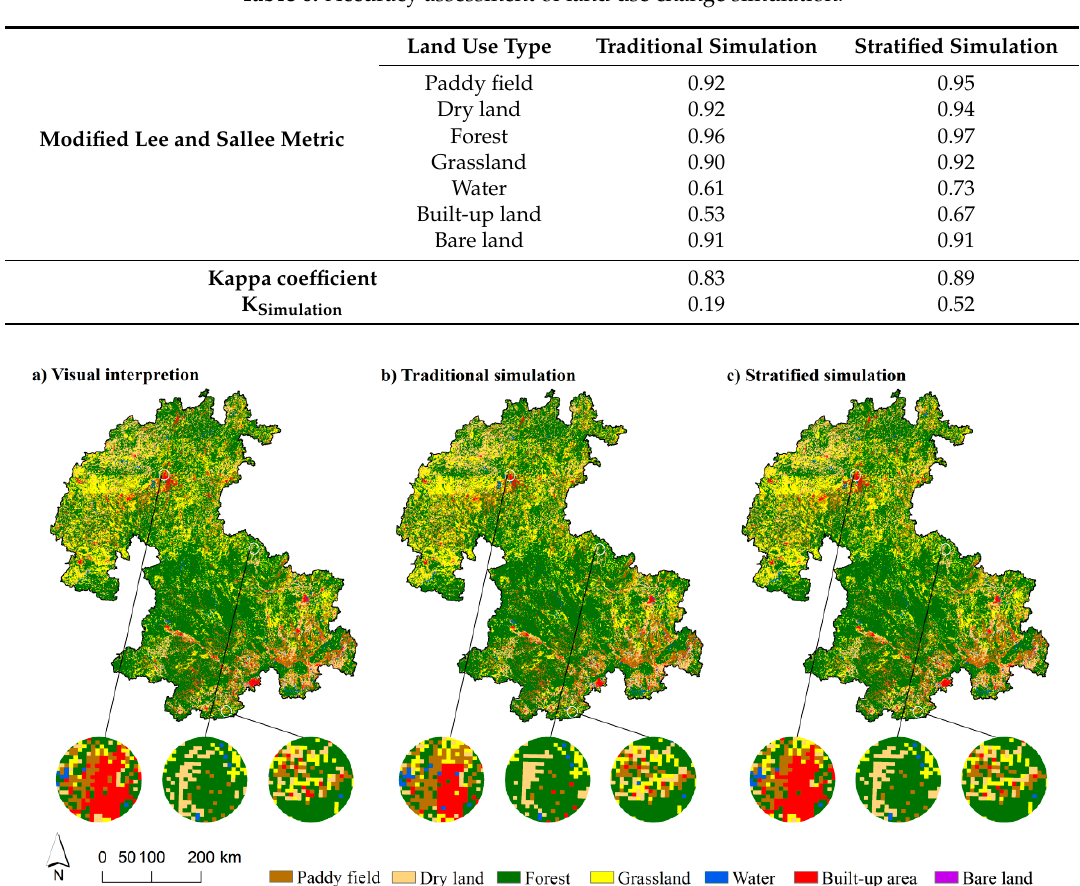
Figure 8. Comparison of land use in 2015 from ( a ) referenced visual interpretation; ( b ) traditional simulation; ( c ) stratified simulation.